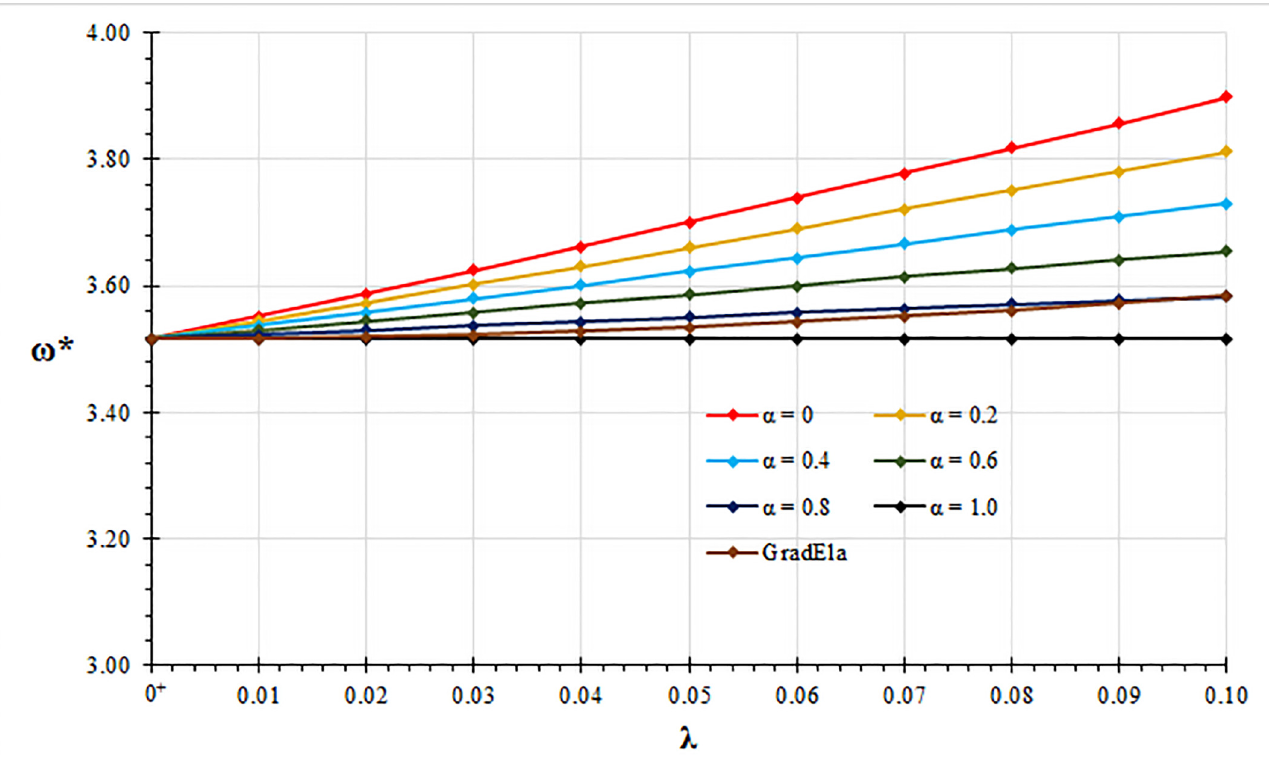
Figure 2. Cantilever beam: non-dimensional fundamental natural frequency ω ∗ vs. nonlocal parameter λ for α ∈ { 0, 0.2, 0.4, 0.6, 0.8, 1.0 }